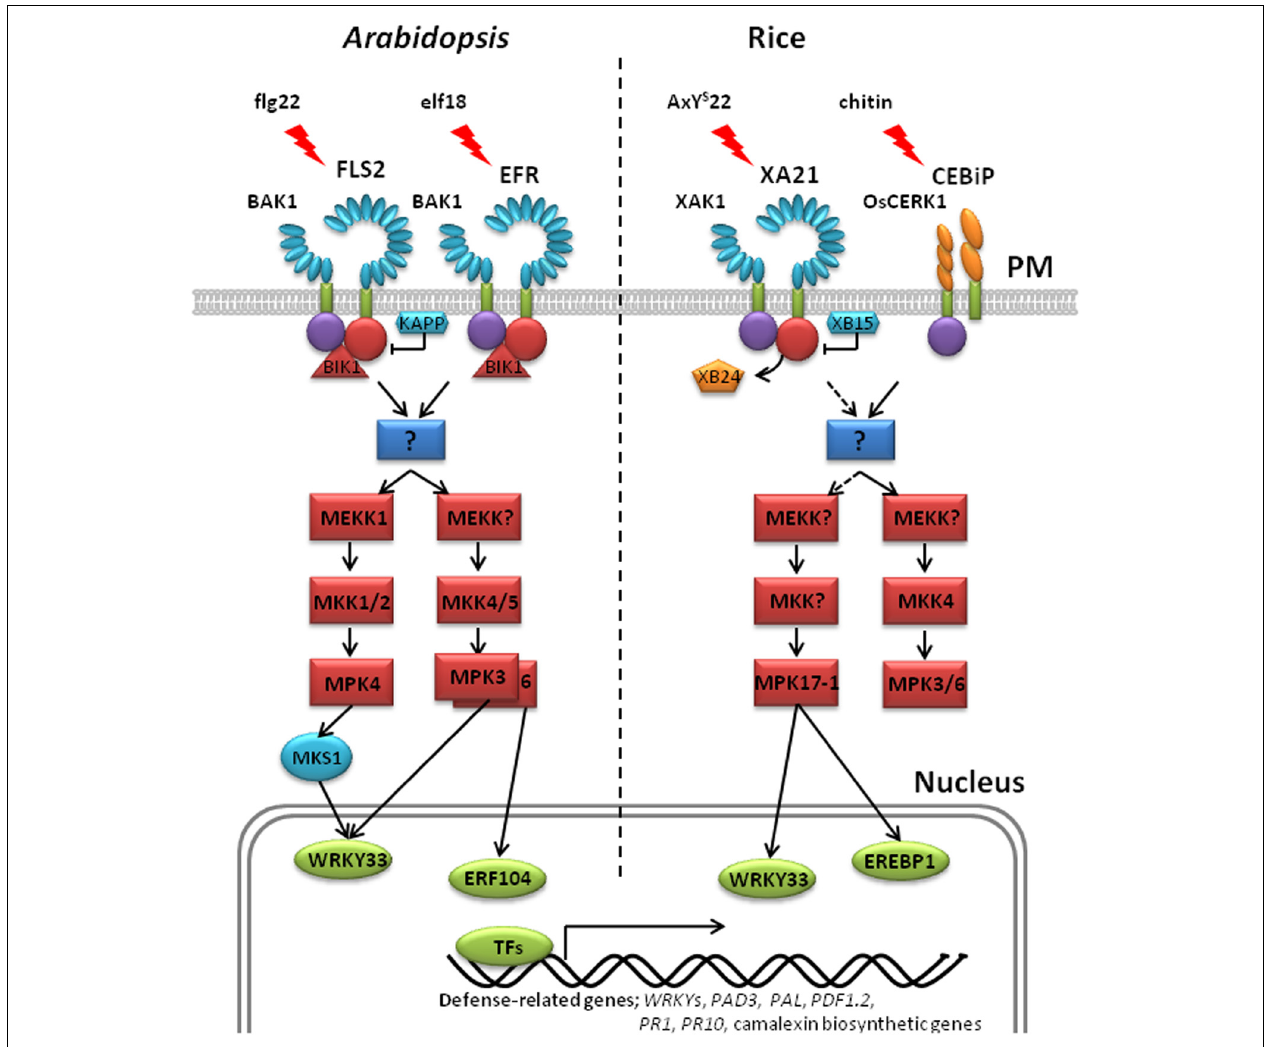
ATPase, XB24, and the XA21-associated kinase, XAK1. Association of XAK1 and XA21 requires the XA21 JM and kinase domains. Binding of AxY S 22 to XA21 induces dissociation of XA21 from XB24 and activates XA21, triggering autophosphorylation. Activated XA21 likely activates a MAPK cascade that includes MPK17-1, leading to the phosphorylation of the transcription factors, OsWRKY33 and OsEREBP1. Recruitment of XB15 to the XA21 JM domain and subsequent dephosphorylation of phosphorylated residue(s) attenuates XA21 signaling. Cleavage of XA21 and translocalization of the intracellular kinase domain to the nucleus is required for the XA21-mediated immune response (Park and Ronald, 2012). Unlike other well-characterized PRRs, the rice receptors CEBiP and OsCERK1 contain extracellular LysM (lysine motif) domains in place of LRR domains (Kaku etal., 2006; Shimizu etal., 2010). Upon chitin perception, the CEBiP and OsCERK1 complex activates MAPK cascades. In Arabidopsis and rice, phosphorylation of transcription